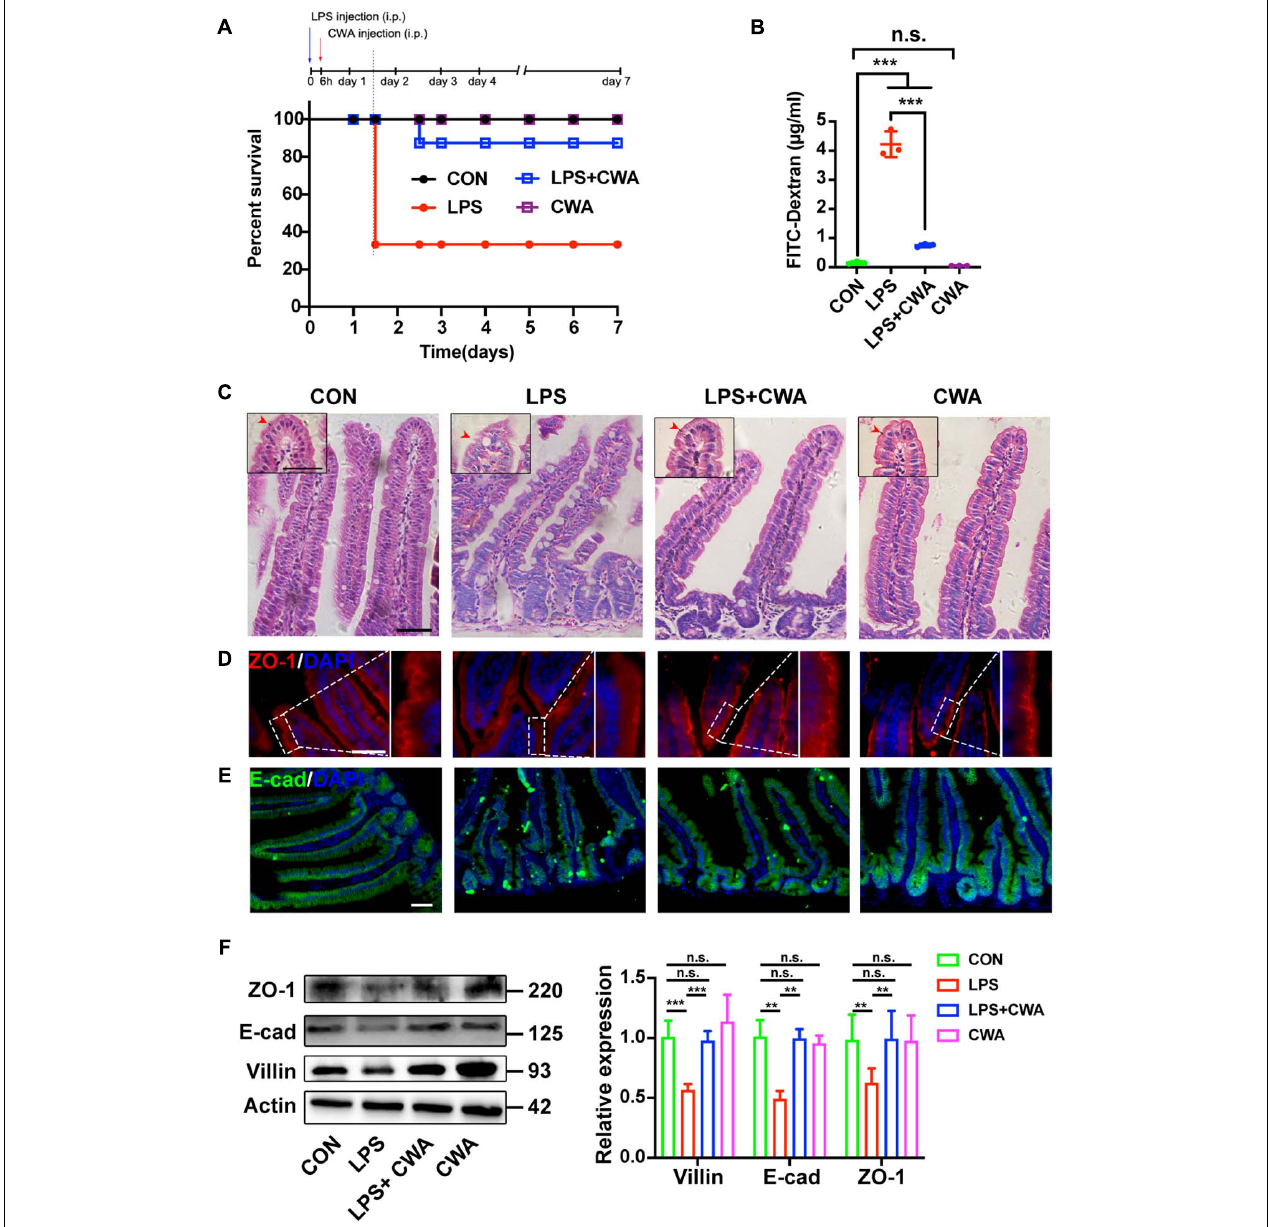
FIGURE 2 | CWA protects against LPS-induced gut injury and animal death. (A) Survival was monitored daily for 7 days. ( n = 10 mice). (B) Gut permeability was determined by FITC-dextran. FITC (fluorescein isothiocyanate)-dextran recovered from the serum 3 h after oral gavage. (C) H&E images of villous structure, the red border outside the villi indicates brush border which is composed by microvilli. Boxed region indicates magnified view of microvilli. red arrows indicate length of microvilli. (D,E) Representative images of ZO-1 (D) and E-cadherin (E) staining in thin sections of jejunum. (F) Western blot analysis of ZO-1, E-cad, and villin expression in small intestinal tissues. Scale bars, 50 µ m. *** P < 0.001, ** p < 0.01 by two-sided, unpaired t -test. All data represent at least three independent